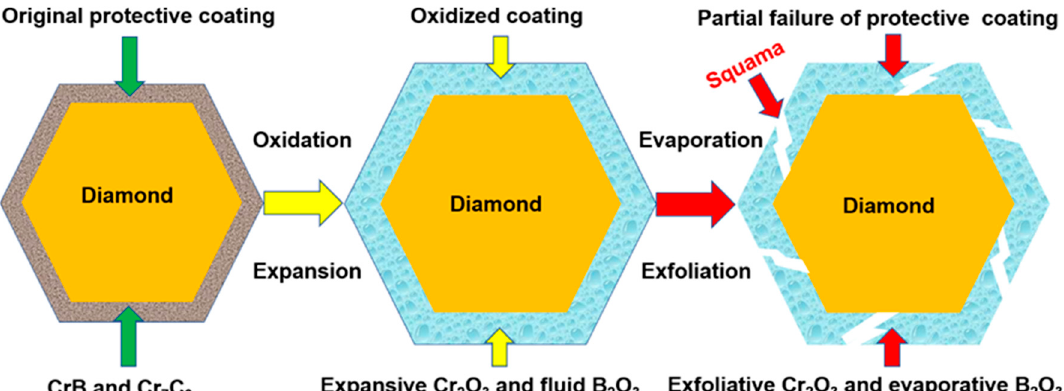
Figure 9. Schematic illustration of the oxidation mechanism related to the Cr–B–C coated diamond.